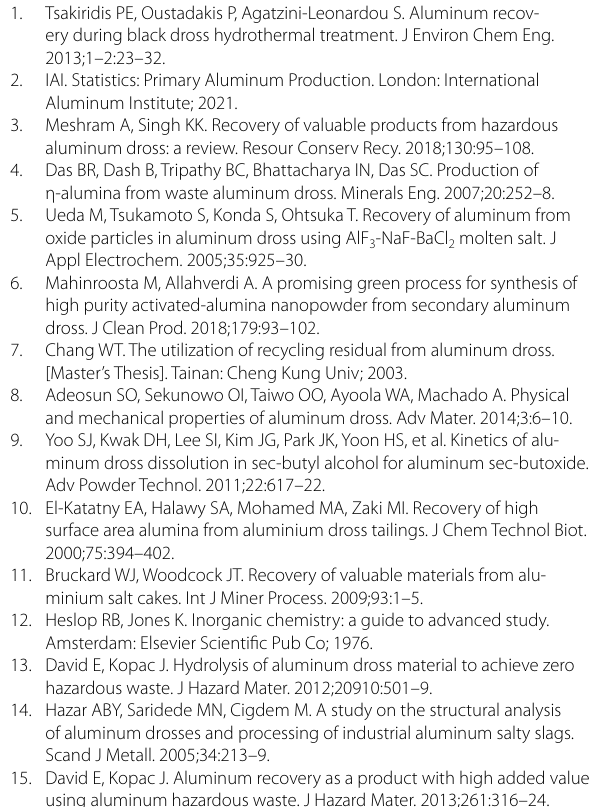
Fig. 13b. The specific surface area of the α-Al 2 O 3 cal- cinated by atmospheric pressure microwave plasma was only 6 m 2 g − 1 with SEM image shown in